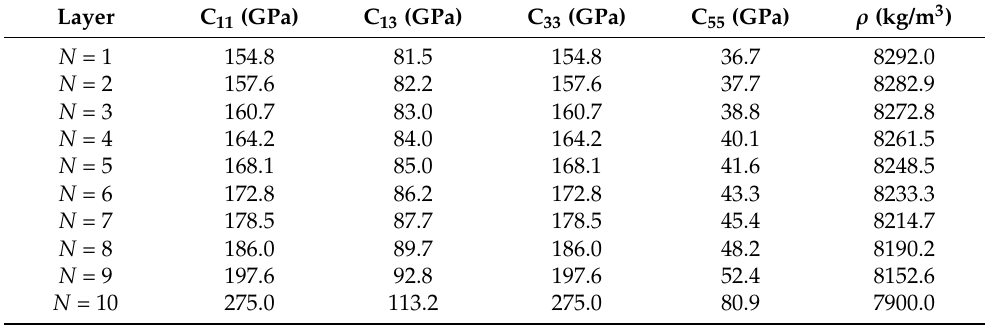
Table 2. Parameters of sliced FGM layer.